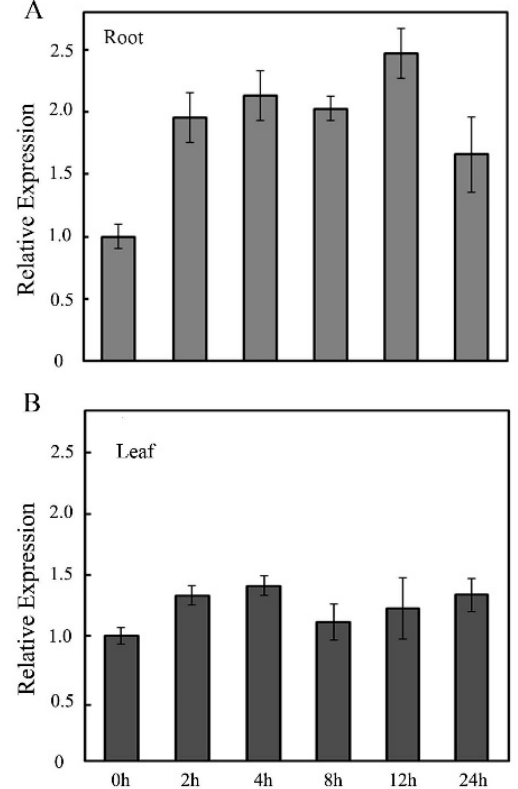
Figure 1. Salt induces OsVTC1-3 expression in root. ( A ) The expression patterns of OsVTC1-3 in rice roots under salt treatment were analyzed by qPCR. ( B ) The expression patterns of OsVTC1-3 in rice leaves under salt treatment were analyzed by qPCR. After normalizing to internal control Actin , the transcript level of OsVTC1-3 under control conditions (0 h) was assigned as “1”, and this figure shows the expression level of OsVTC1-3 at other time point relative to 0 h. The experiments were repeated three times. The bars represent the SE (±) of three independent assays.